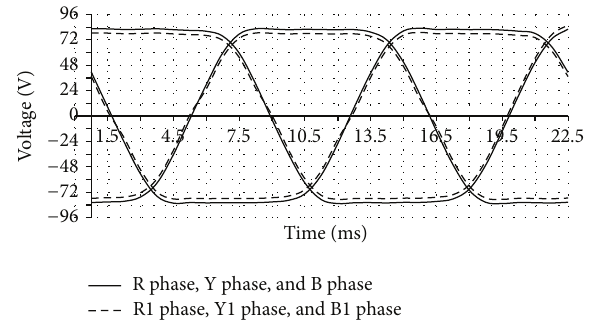
Figure 12: Induced emf before and after cogging torque reduction. Table 3: Percentage reduction in cogging torque and induced